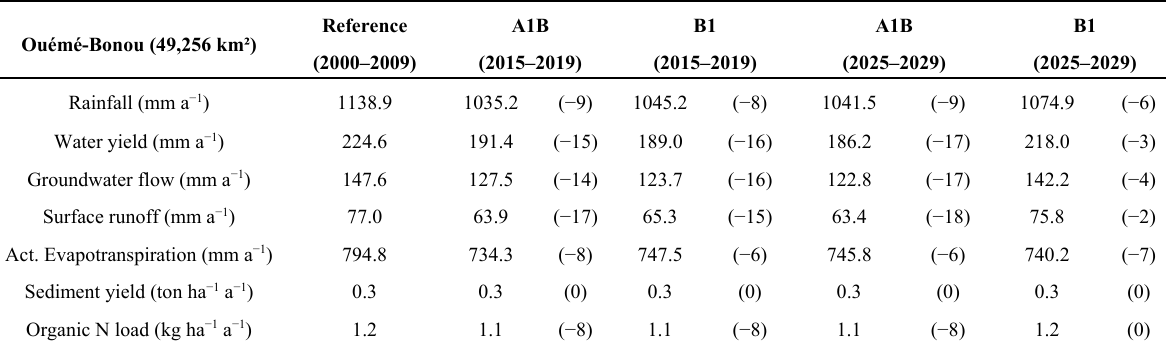
Table 9. Simulated SWAT components under climate scenarios (with unchanged land use map derived from 2003 Landsat image). Deviation (in %) from the reference scenario (2000–2009) are shown in